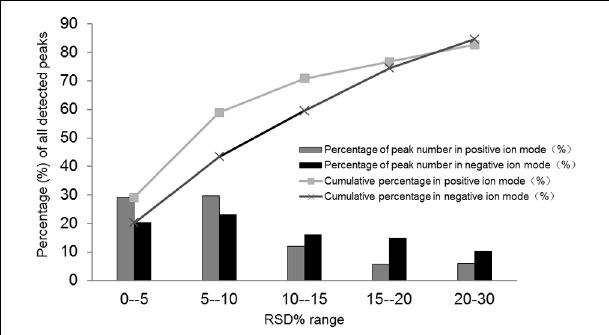
FIGURE 3 | Relative standard deviation (RSD%) distribution of all metabolites in the pooled quality control (QC) samples.